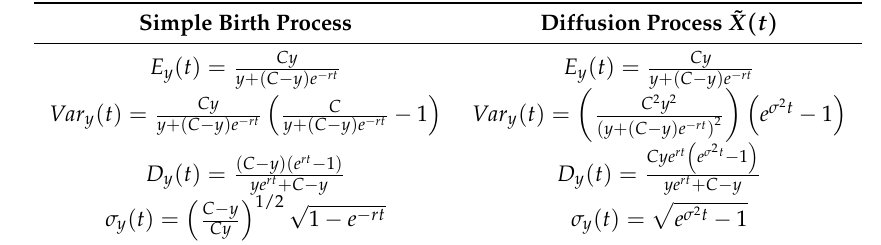
Table 7. Some comparisons between the simple birth process of Section 4 and the diffusion process with infinitesimal moments (49).